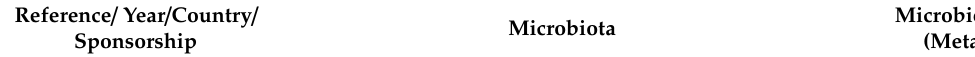
Table 2. Microbiota and gut-barrier-related